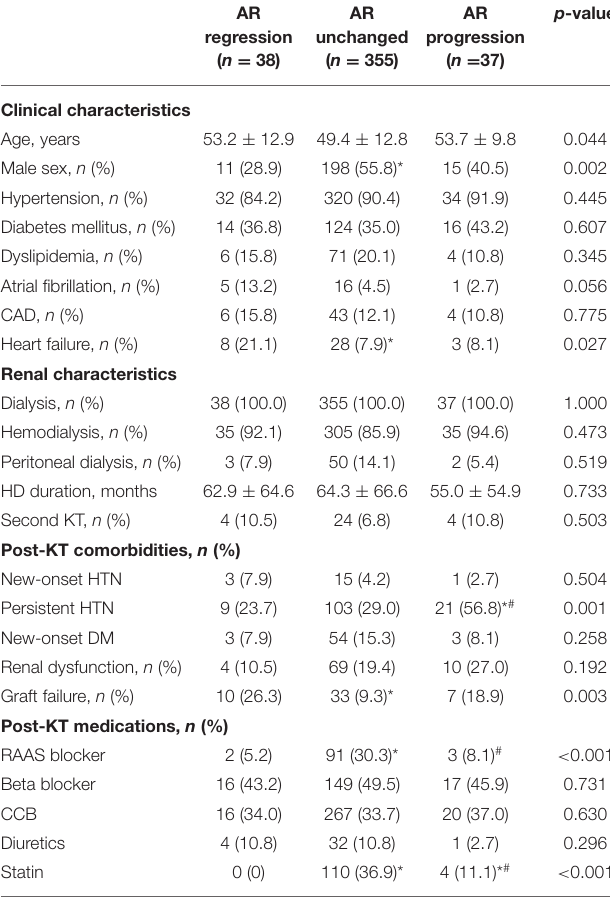
TABLE 4 | Comparison of clinical and renal characteristics in the three groups according to change in aortic regurgitation. AR